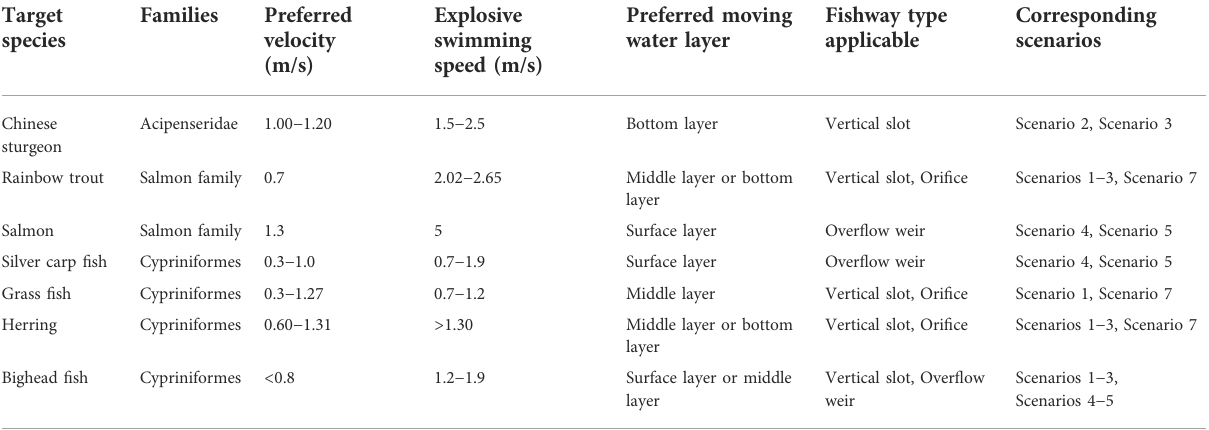
TABLE 10 Selection of fi shway based on the swimming ability of several typical fi